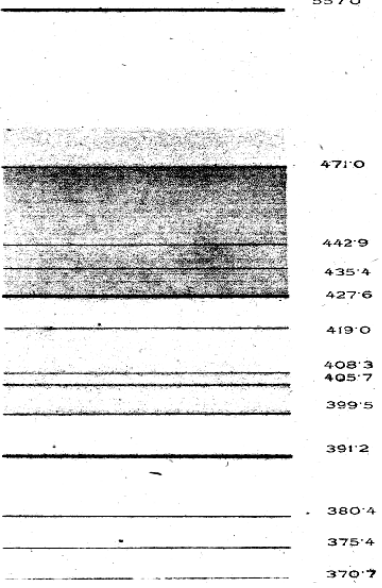
Fig. 13. Synthetic spectrum constructed by Sykora on the basis of his data.